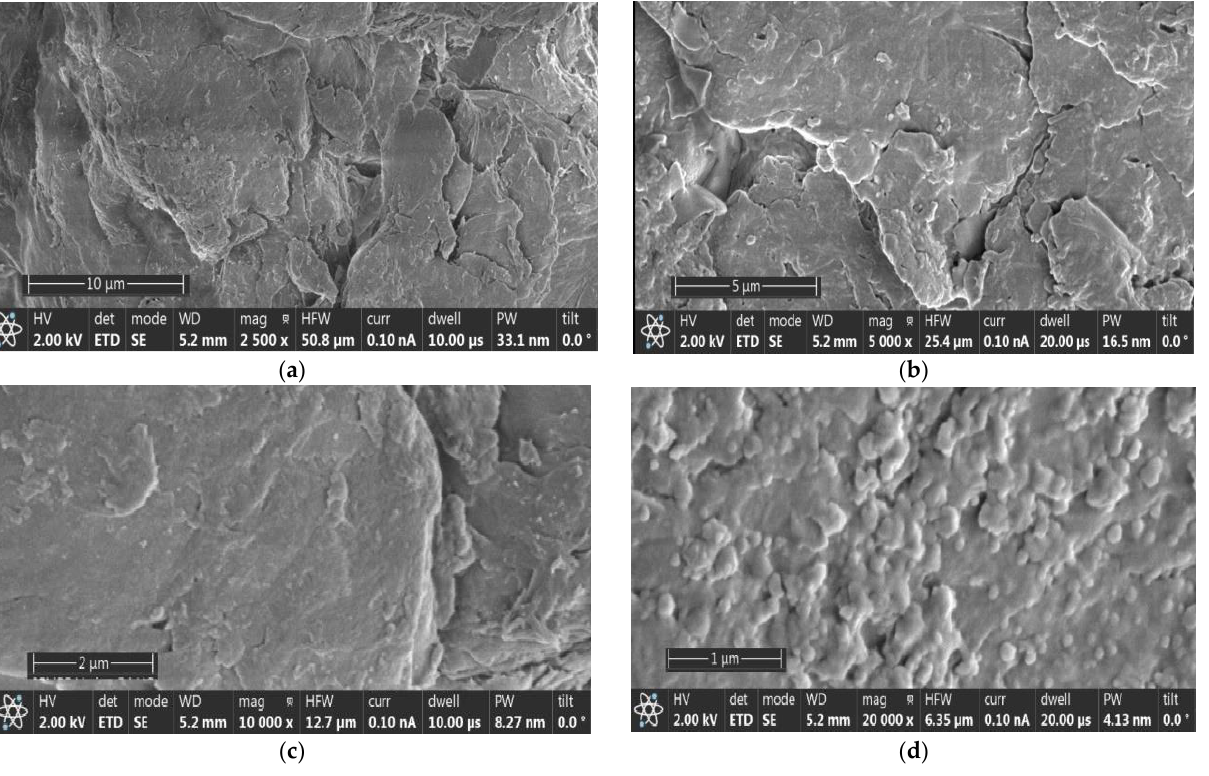
Figure 3. SEM images of chitin forms separated from the CB deproteinization liquid extract: ( a ) 2500× mag-10 µm scale; ( b ) 5000× mag-5 µm scale; ( c ) 10,000× mag-2 µm scale; ( d ) 20,000× mag-1 µm